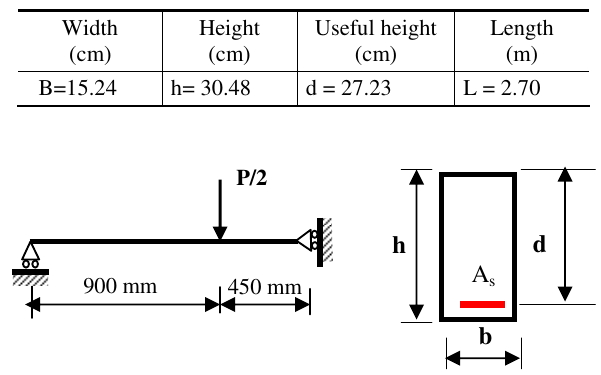
Table 3. Geometry properties of section (Fig. 7)